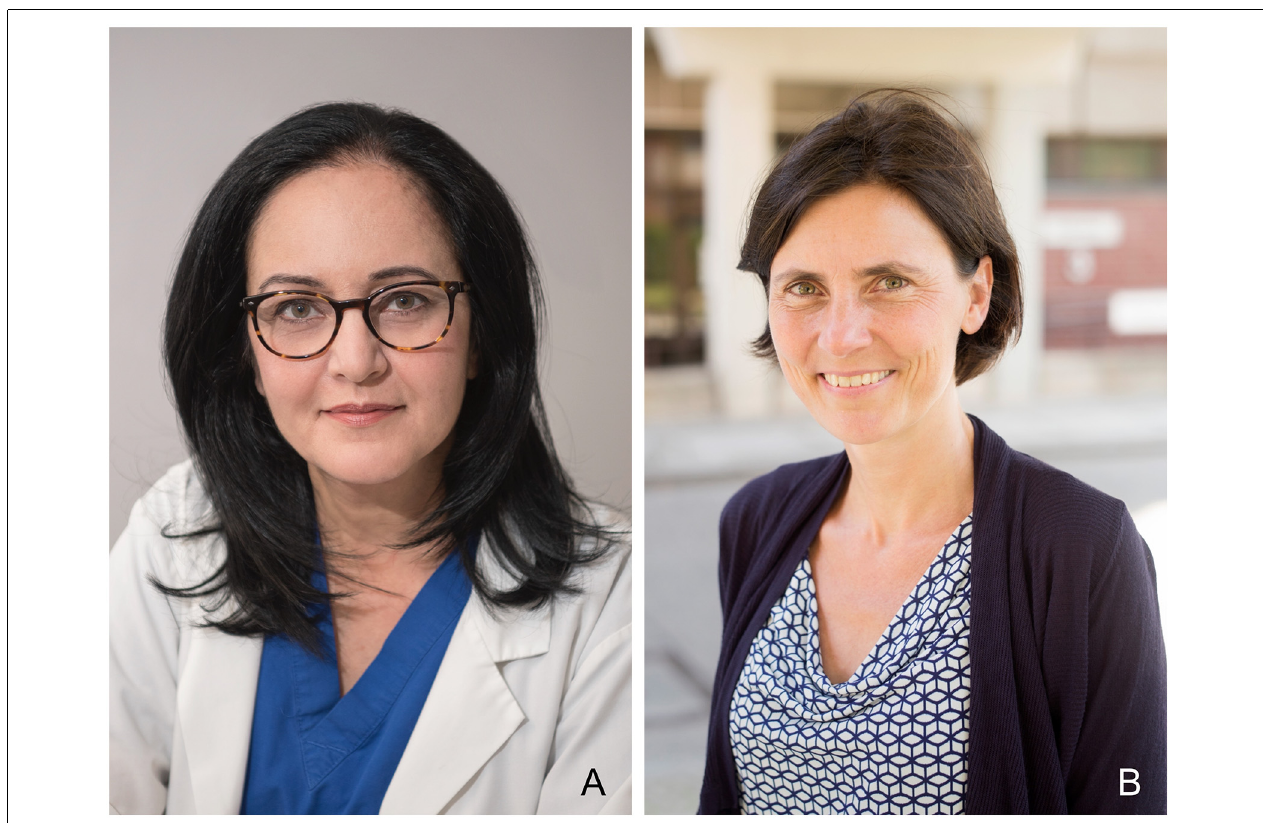
FIGURE 14 | (A) Mojgan Hodaie, provided by Mojgan Hodaie. (B) Andrea Kühn, provided by Andrea